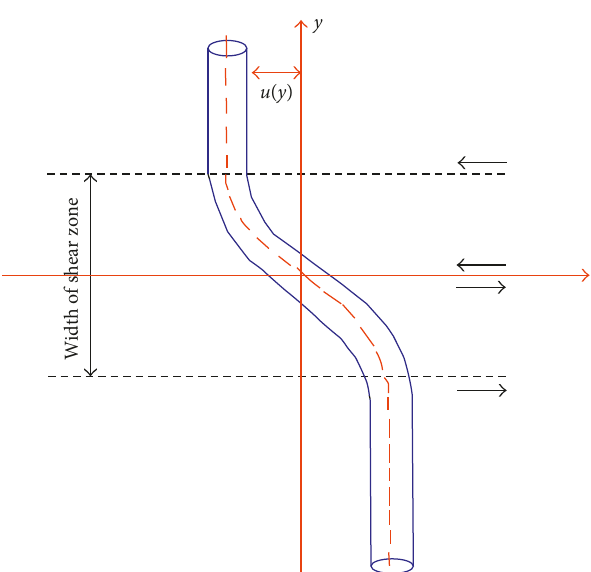
Figure 4: Sketch for “S” typed deformation of casing.